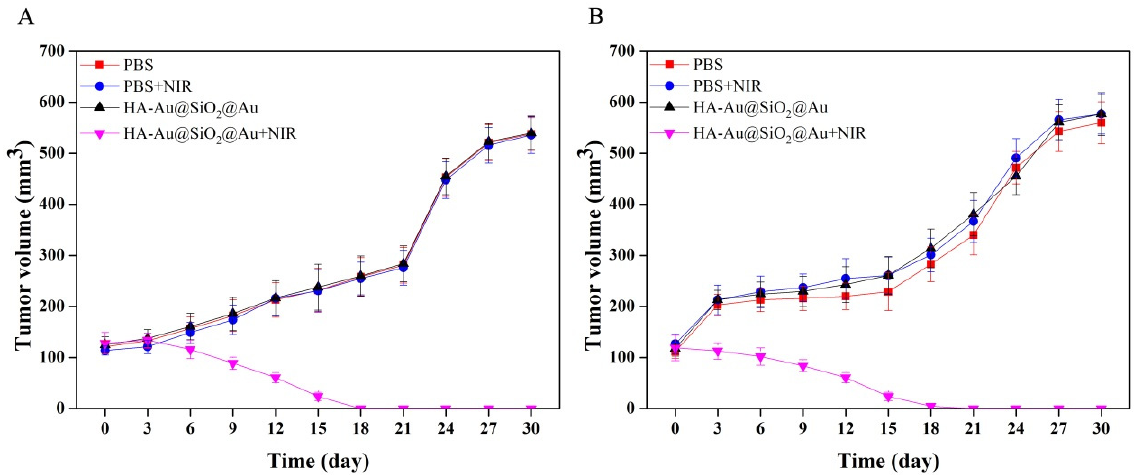
Figure 5. In vivo photothermal therapy of tumors. Volume changes of ( A ) prostate tumor models and ( B ) bladder tumor models.